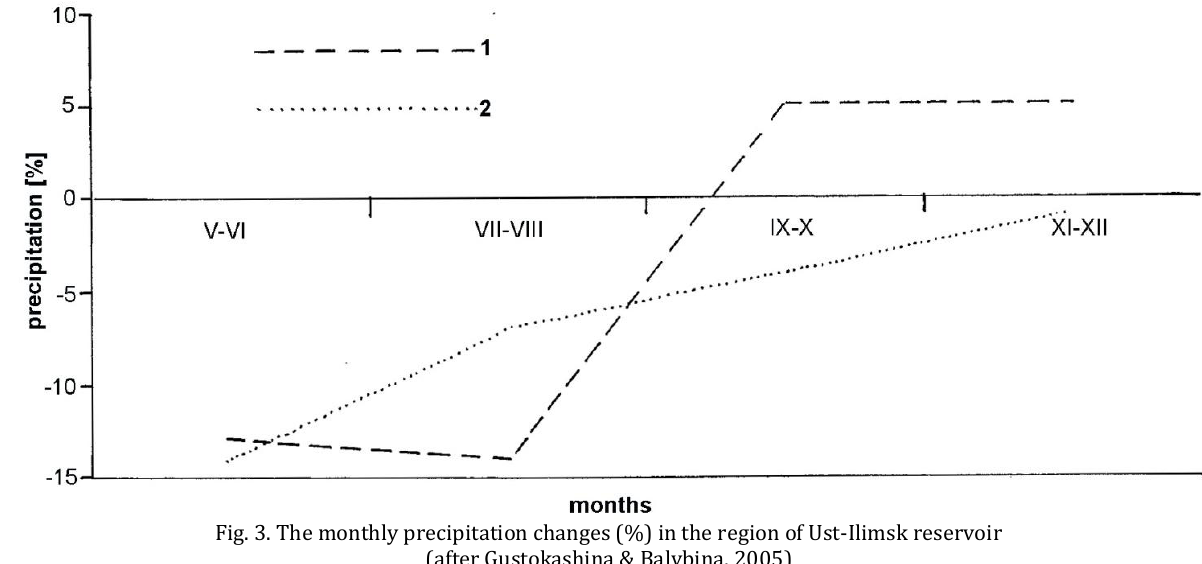
Fig. 3. The monthly precipitation changes (%) in the region of Ust-Ilimsk reservoir (after Gustokashina & Balybina, 2005) 1 – coastal stations; 2 – continental